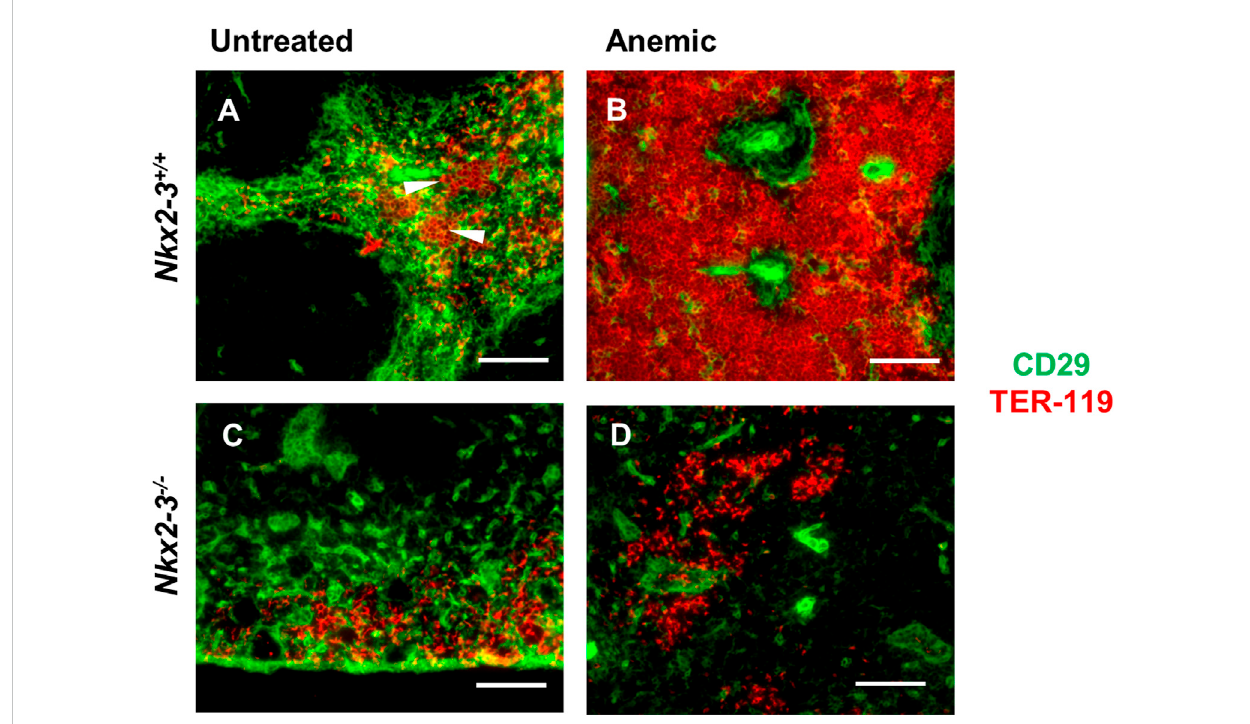
FIGURE 6 Defective extramedullary expansion of splenic erythroid colonies in mice lacking Nkx2-3 compared to wild-type mice. Compared to untreated controls (A) , in anemic BALB/c mice the TER-119-positive erythroid colonies (red, arrowheads) embedded in CD29-positive stroma (green)